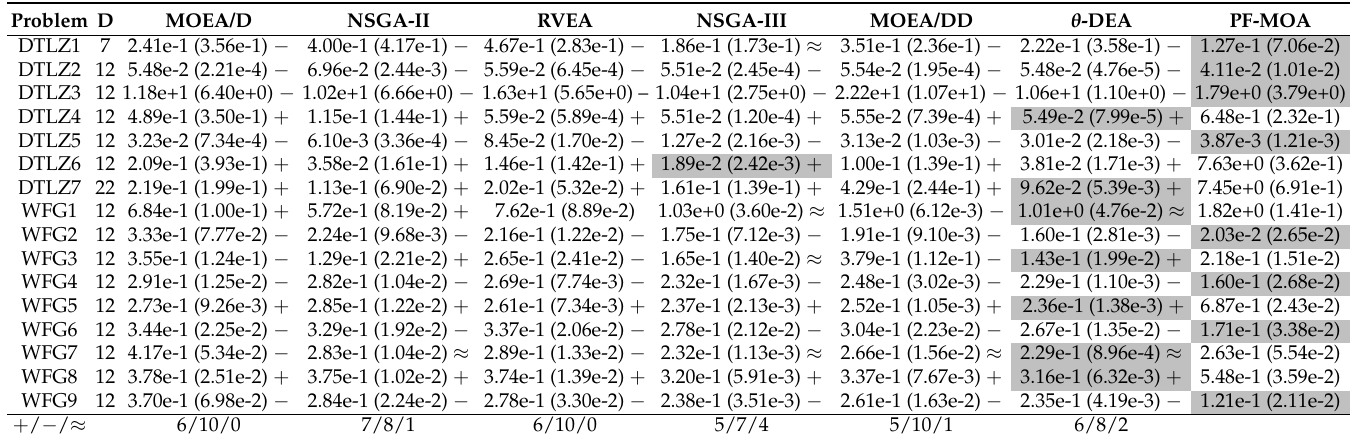
Table 1. Statistical results of the IGD values obtained by NSGA-II, RVEA, MOEA/D, MOEA/DD, NSGA-III, θ -DEA and PF-MOA with the same number of real function evaluations.